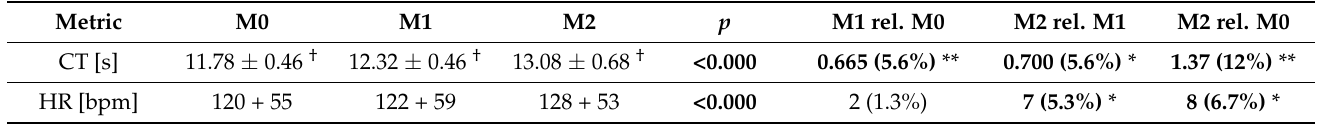
Table 3. Energy expenditure, muscle parameters, and kinematic parameters for three loading conditions of one subject ( n = 1), pre- sented as median + range, ANOVA test results (significant results are in bold), and the differences between loading conditions. Metric